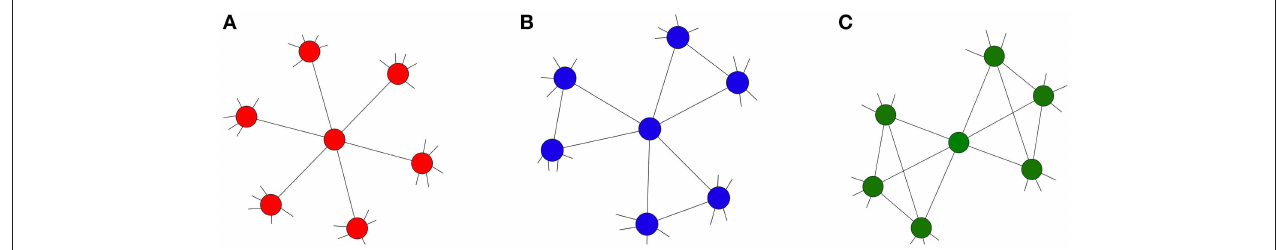
FIGURE 1 | Network topologies, each with degree z = 6 . (A) z -regular network (red) with n n 3 , m 3 and C 0 . 2 ; (C) highly clustered network (green) with n = = △ =